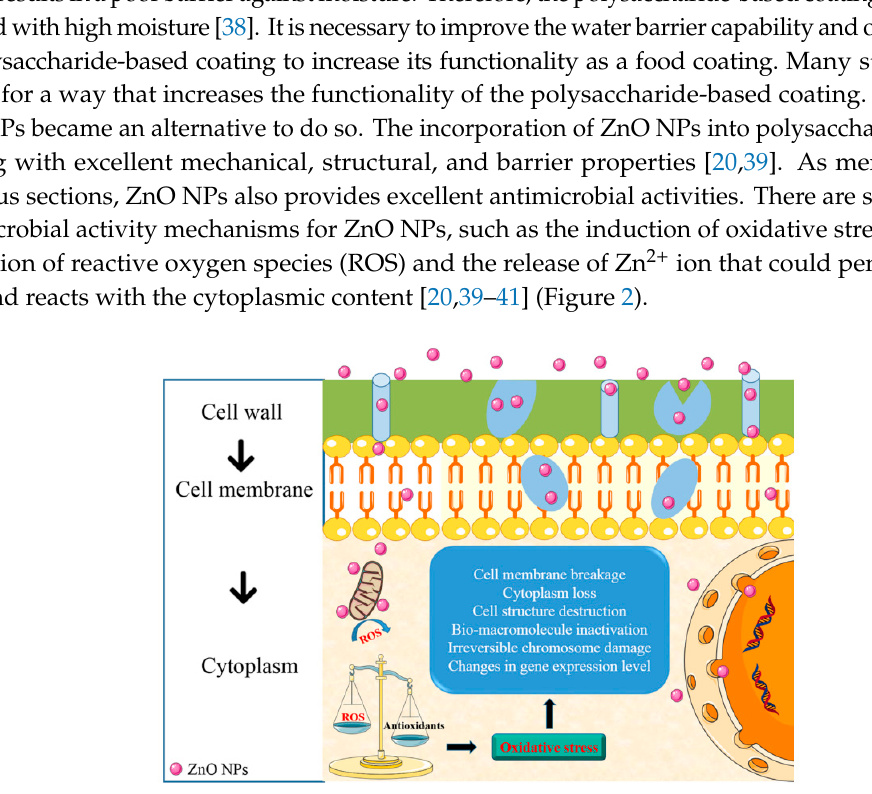
Figure 2. Antimicrobial activities mechanism for ZnO NPs. Reproduced with permission from [20] Copyright 2018, American Chemical Society.